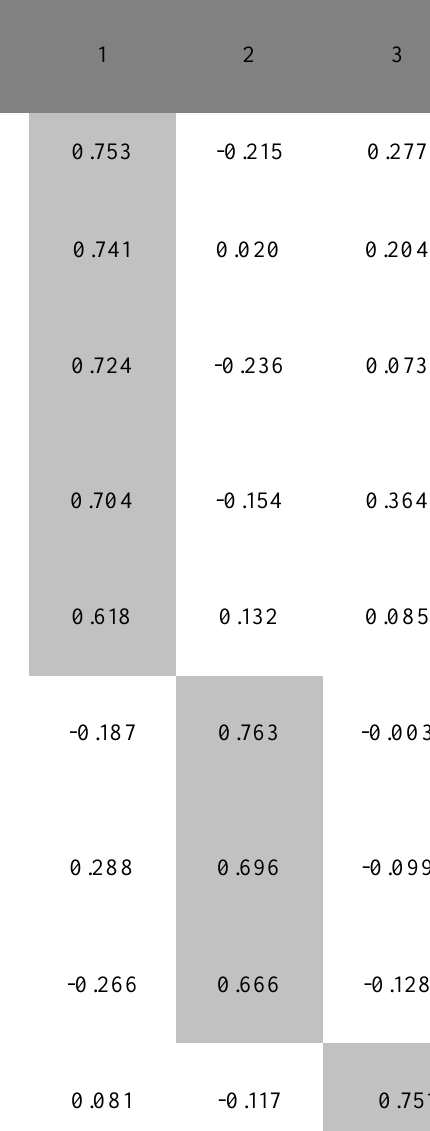
Varimax-Rotated Factor-Loading Matrix